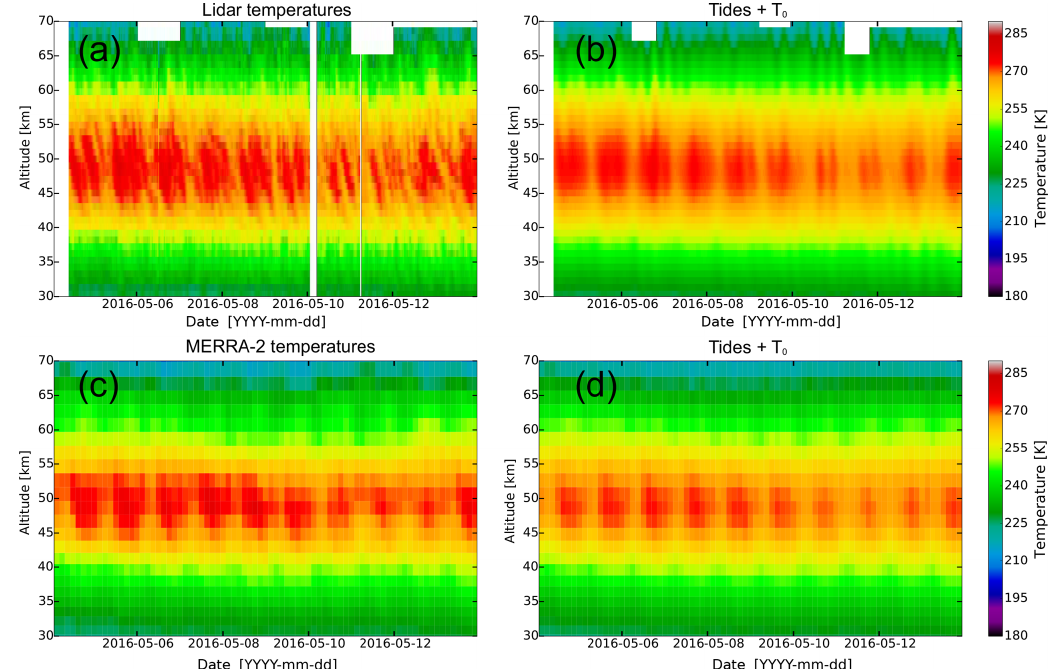
Figure 1. Temperatures and filtered temperature field including tides and background observed by the RMR lidar at Kühlungsborn on 4–13 May 2016 (a, b) , and the corresponding data obtained by MERRA-2 (c, d) .